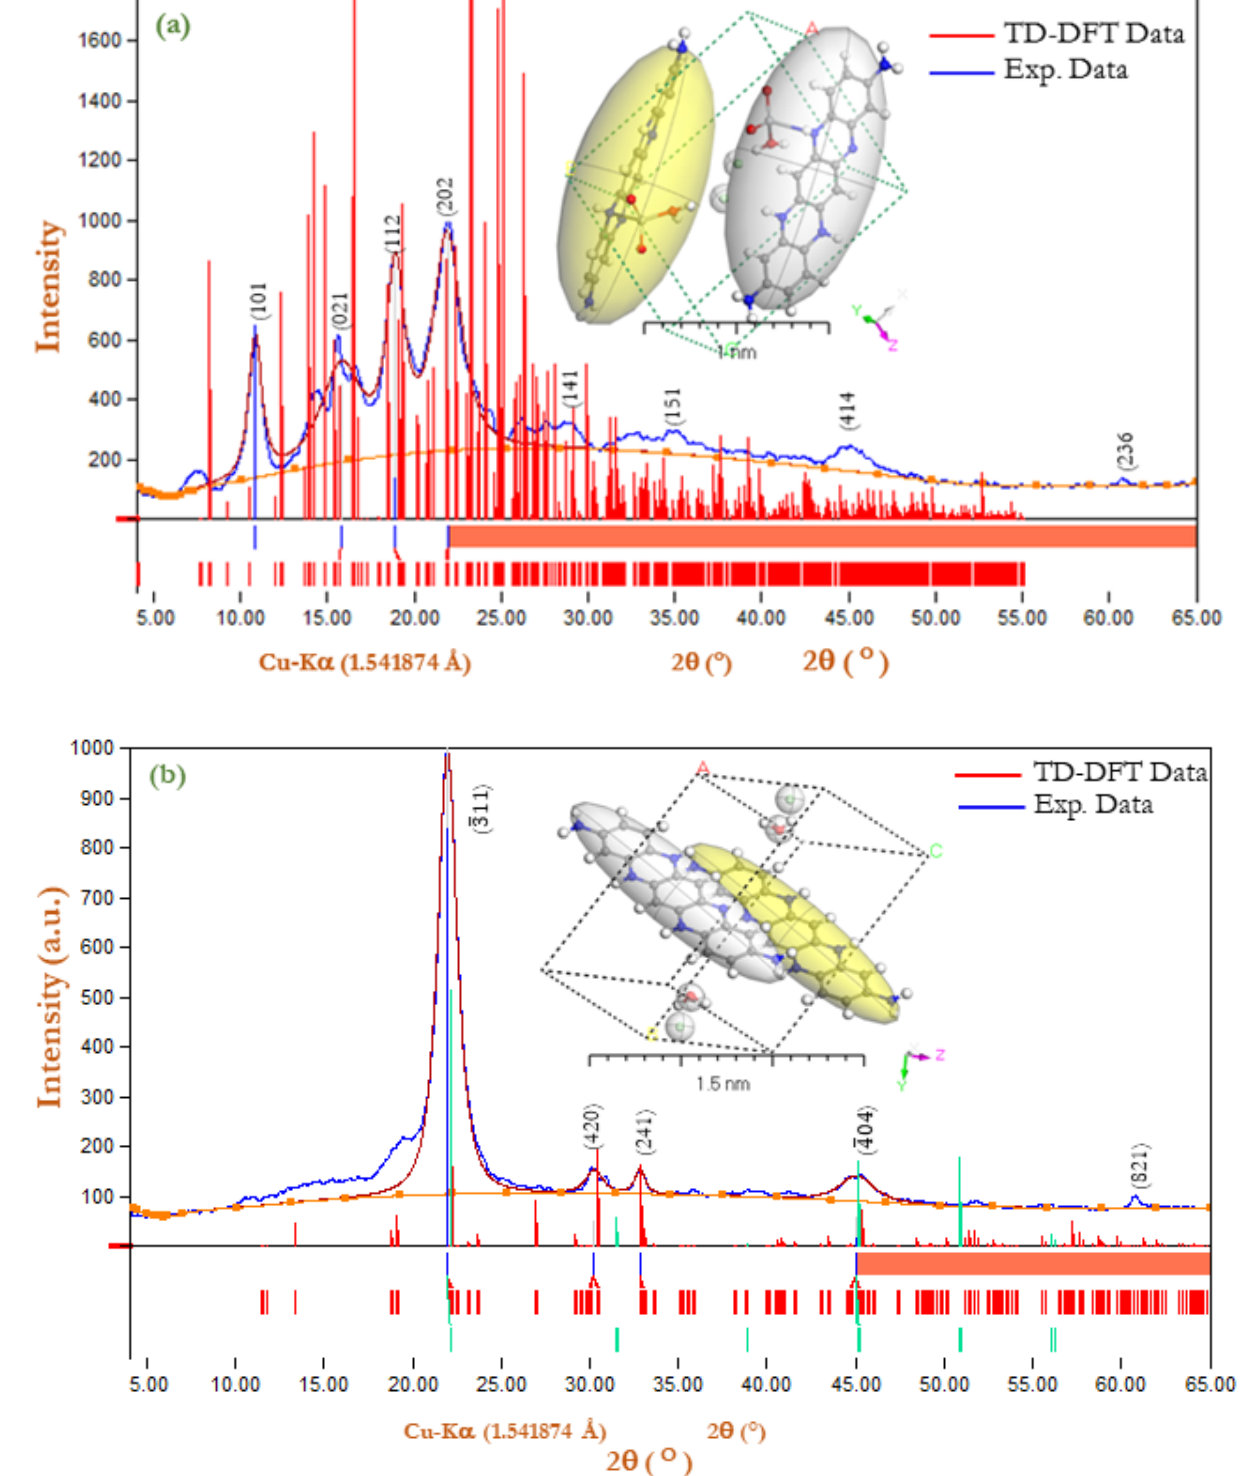
Figure 2. Combined between the experimental [PoPDA]TF and [PoPDA/TiO 2 ]MNC and simulated XRD patterns. Figure (inset) is a 3D Orthorhombic lattice-type and 3D Monoclinic lattice-type